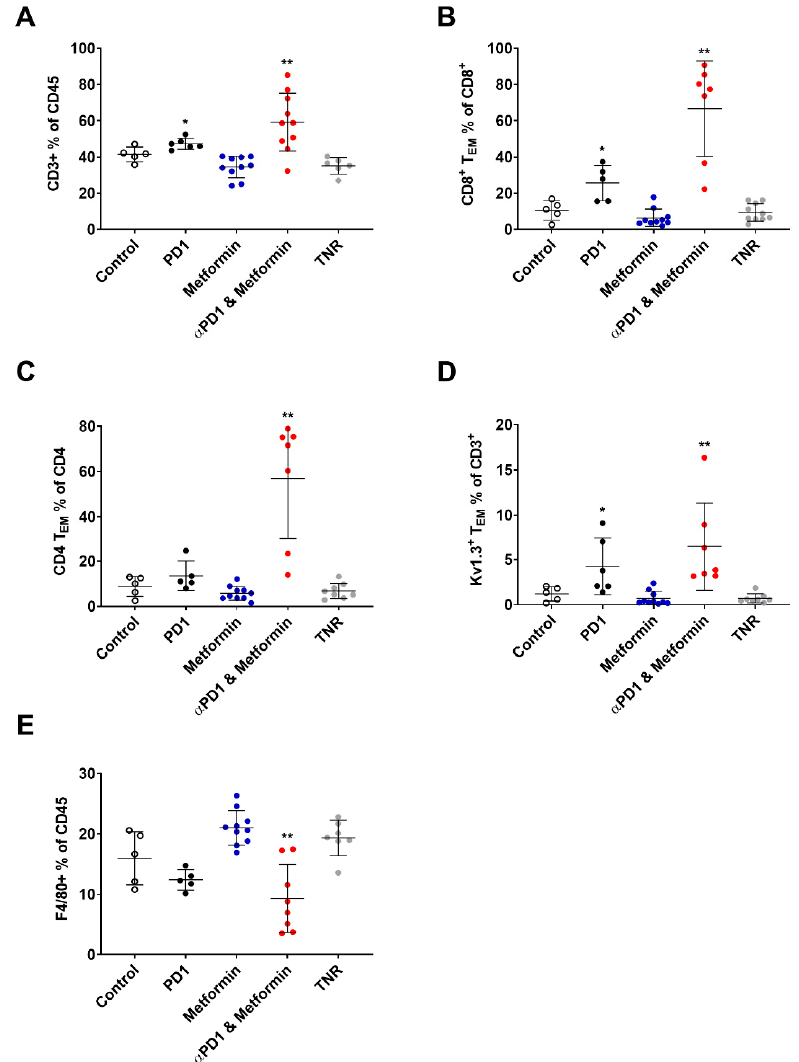
Figure 3. Tumour infiltrating immune cell populations determined using FACS across each treatment cohort (control, α PD1, metformin, combined α PD1 + metformin and TNRs). Data shown as ( A ) CD3 + cells as a % of total CD45 + cells, ( B ) CD8 + T EM cells as a % of total CD8 + cells, ( C ) CD4 + T EM cells as a % of total CD4 + cells, ( D ) K V 1.3 + T EM cells as a % of total CD3 + cells, and ( E ) F4/80 + cells as a % of total CD45 + cells. Data indicated are individual values with mean ± S.D. representative of n = 5–10 mice/cohort. * p < 0.05; ** p < 0.01 compared to TNR. Table 2. Percentages of immune cell populations across each treatment cohort (control, α PD1, metformin, combined α PD1 + metformin and